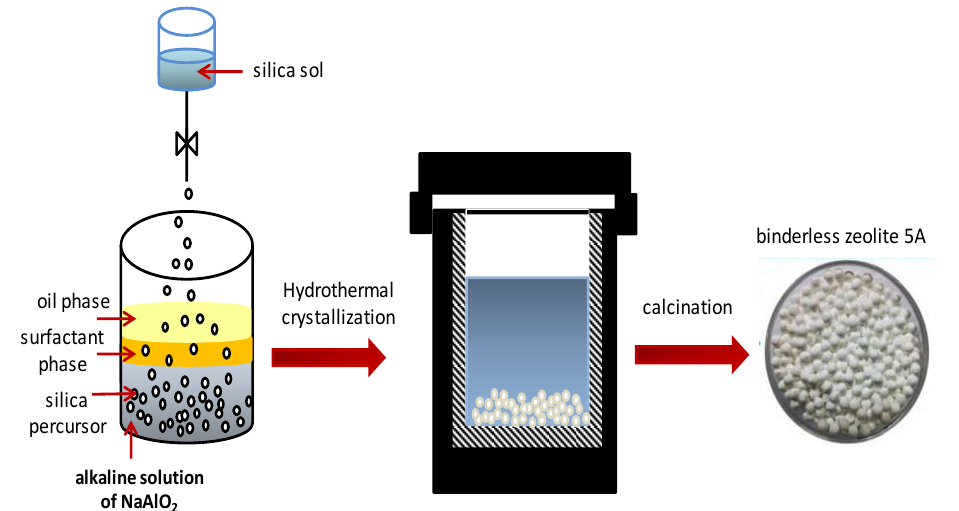
Figure 6. Schematic illustration of one-step synthesis protocol for preparing binder-free granules of zeolite A [94].